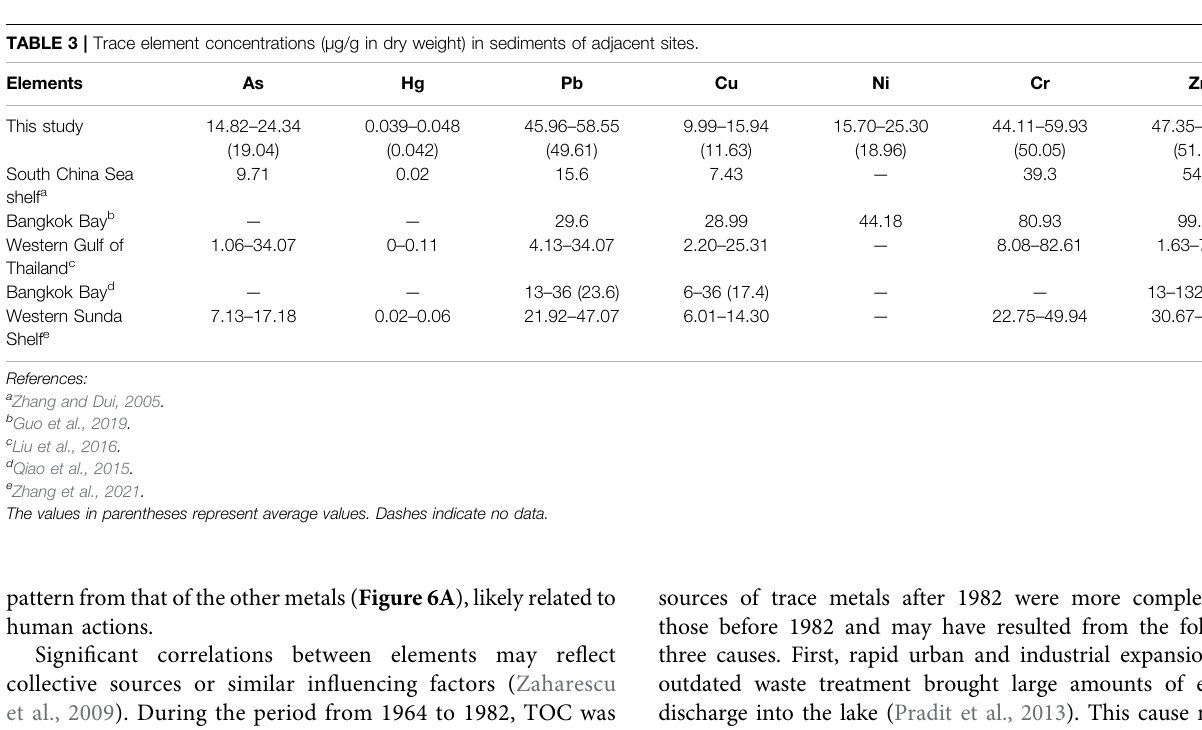
TABLE 3 | Trace element concentrations ( μ g/g in dry weight) in sediments of adjacent